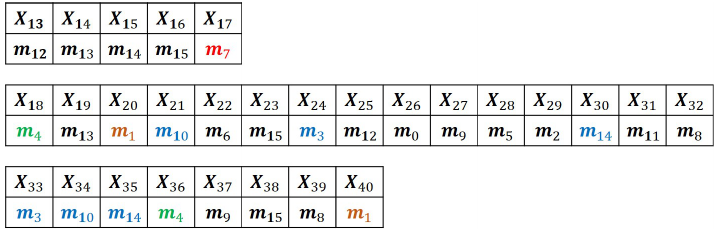
Figure 2: Partial information of the message expansion of RIPEMD-160